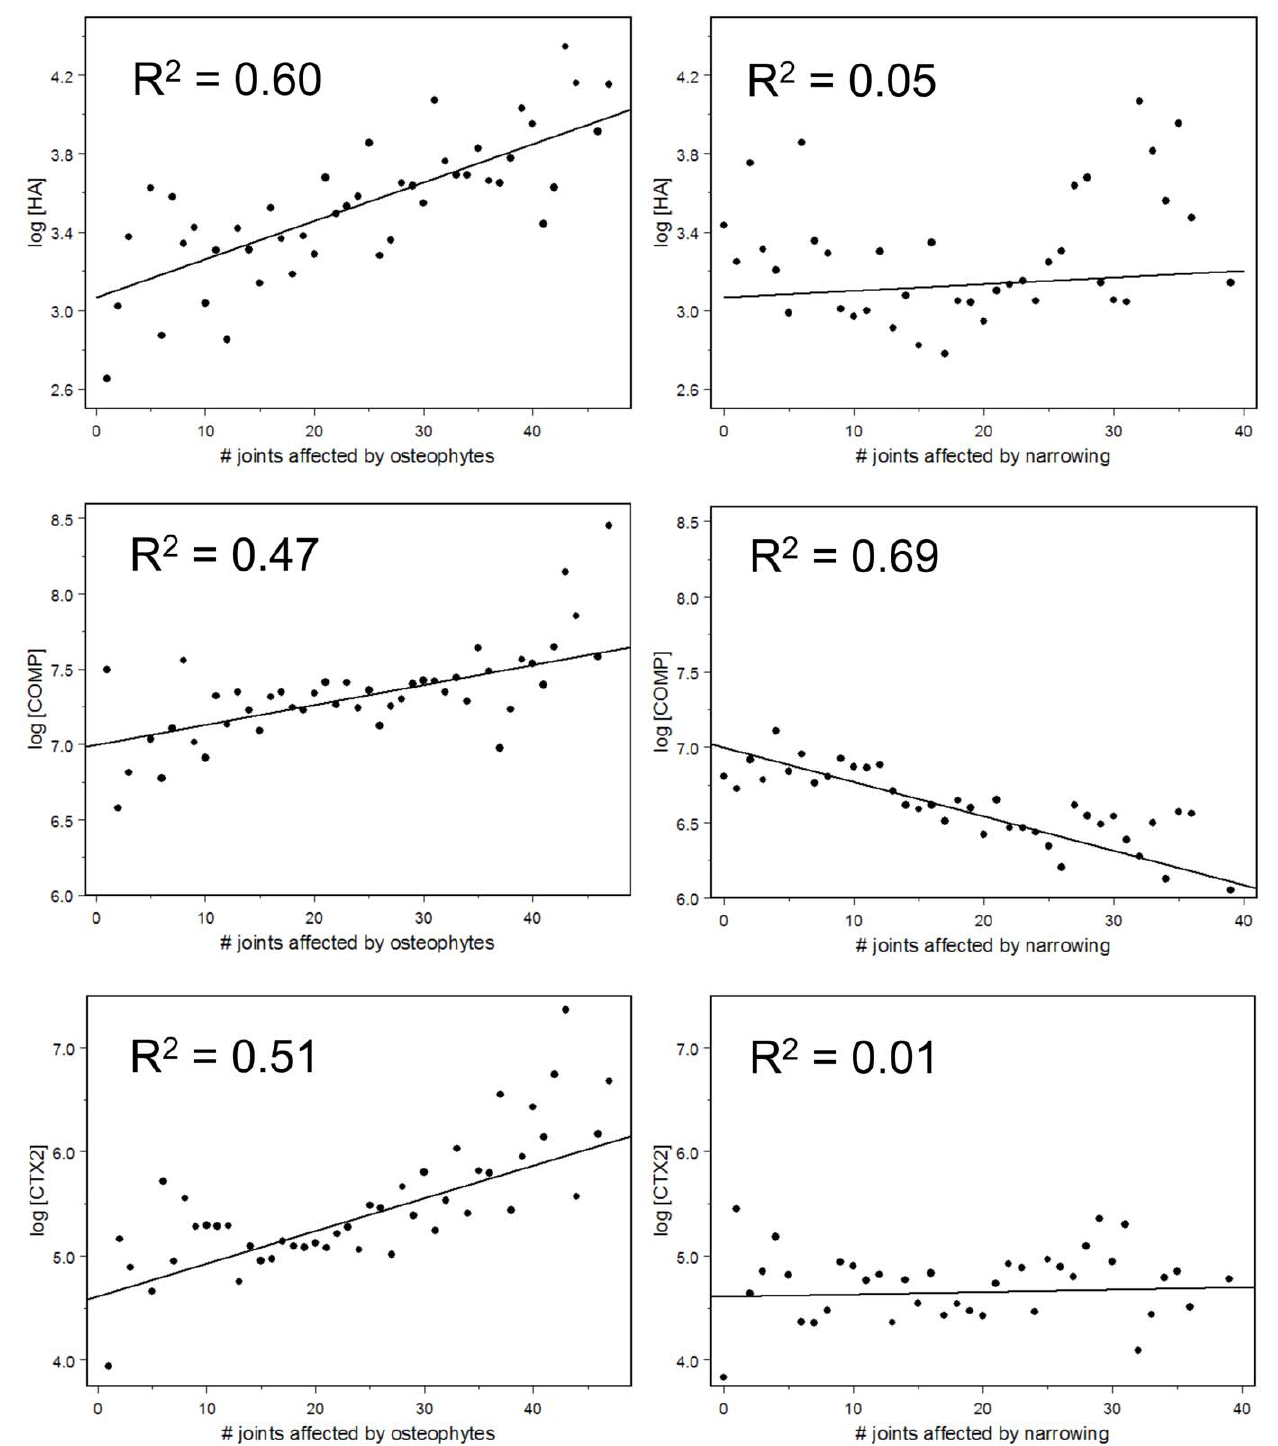
Figure 2. Biomarkers and total burden of OA based on radiographic features (adjusted). The data are restricted to female subjects with complete radiographic and biomarker data. The data were fit to a mixed-effects model, with family as the grouping variable for the random effect. The fixed effects are the numbers of joint faces affected by osteophytes and joint-space narrowing, respectively. Point estimates are plotted for mean serum log s HA (top), log s COMP (middle), and log u CTX2 (bottom) by number of joint faces affected by any osteophyte (grade . 0, left panels), and number of joint faces OA affected by any joint space narrowing (grade . 0, right panels). Joint faces are counted without regard to which joint they belong. JSN point estimates account for OST and OST point estimates account for JSN. In addition, sHA was adjusted for age, log height, log weight; sCOMP was adjusted for age; and CTX2 did not require adjustment. The R 2 values indicated give the proportion of the inter-radiographic class variation explained by the regression. The respective generalized R 2 values for the variance explained by the radiographic features are 4.4%, 6.2%, and 10.2%. All p-values for the weighted regressions are less than 10 2 6 , except for the pairing of s HA and JSN (p=0.18), and u CTX2 and JSN (p=0.51).